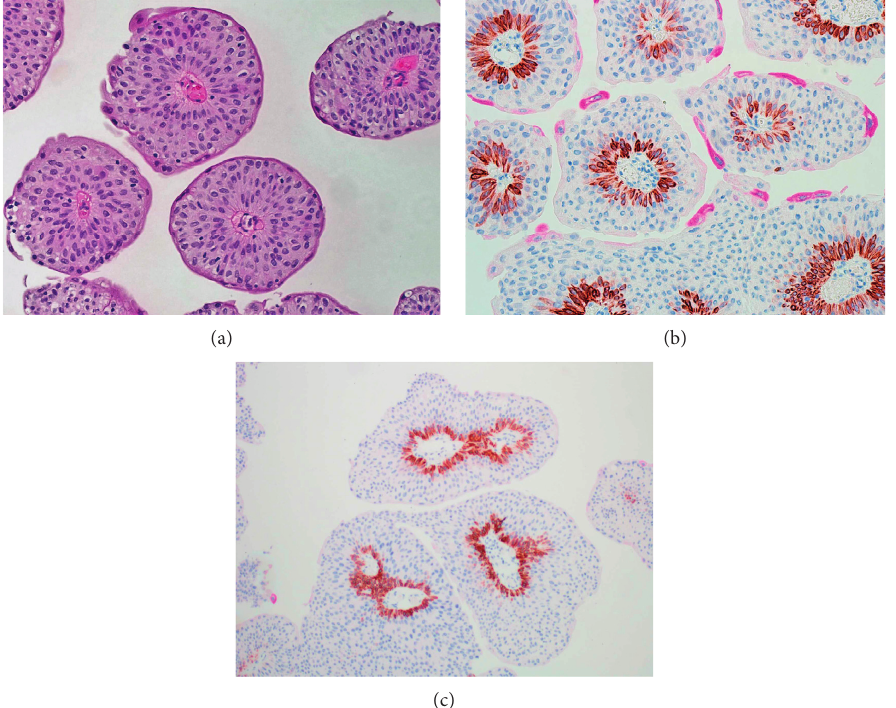
Figure 2: (a) Low-grade papillary urothelial carcinoma. (b) Immunohistochemical stain depicting the CK20 (magenta) expression limited to the umbrella cells and a well-formed basal layer depicted by CK5/6 staining (brown). (c) Low-grade urothelial carcinoma with staining of basal cells but lacking umbrella